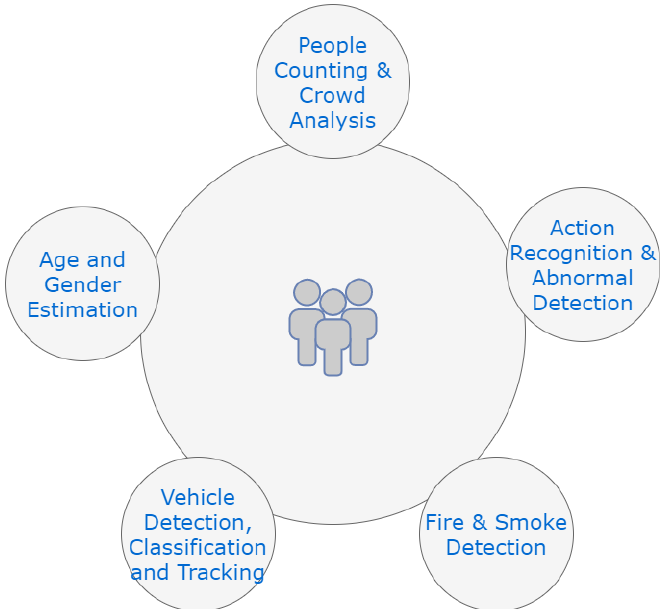
Figure 4. End Users